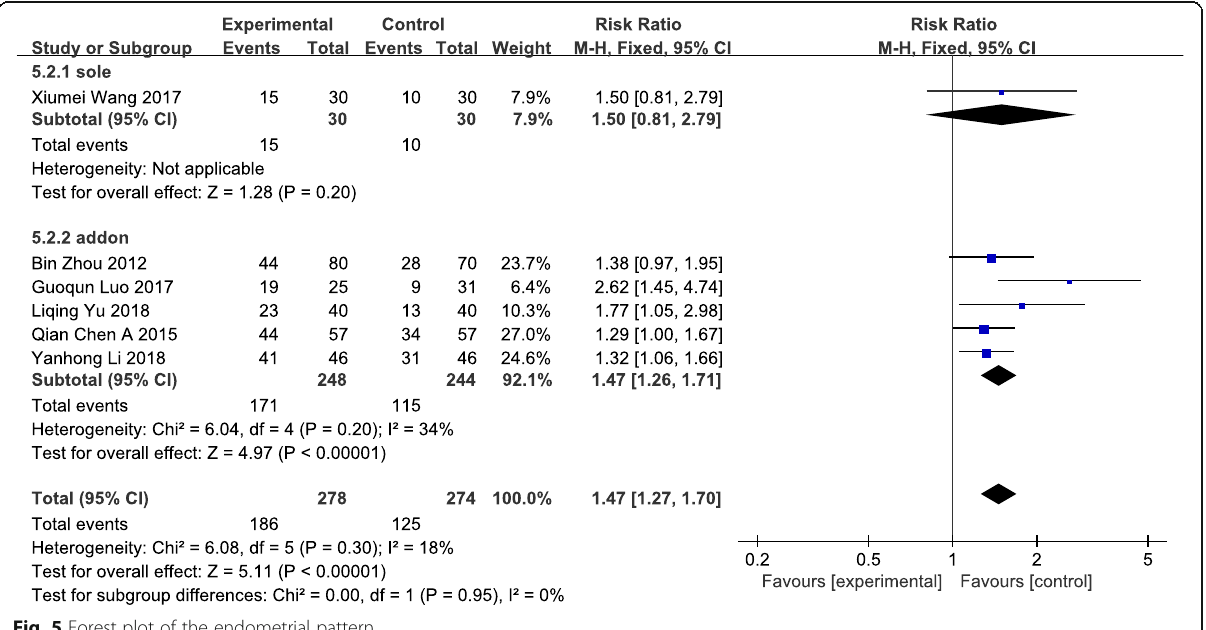
Fig. 5 Forest plot of the endometrial